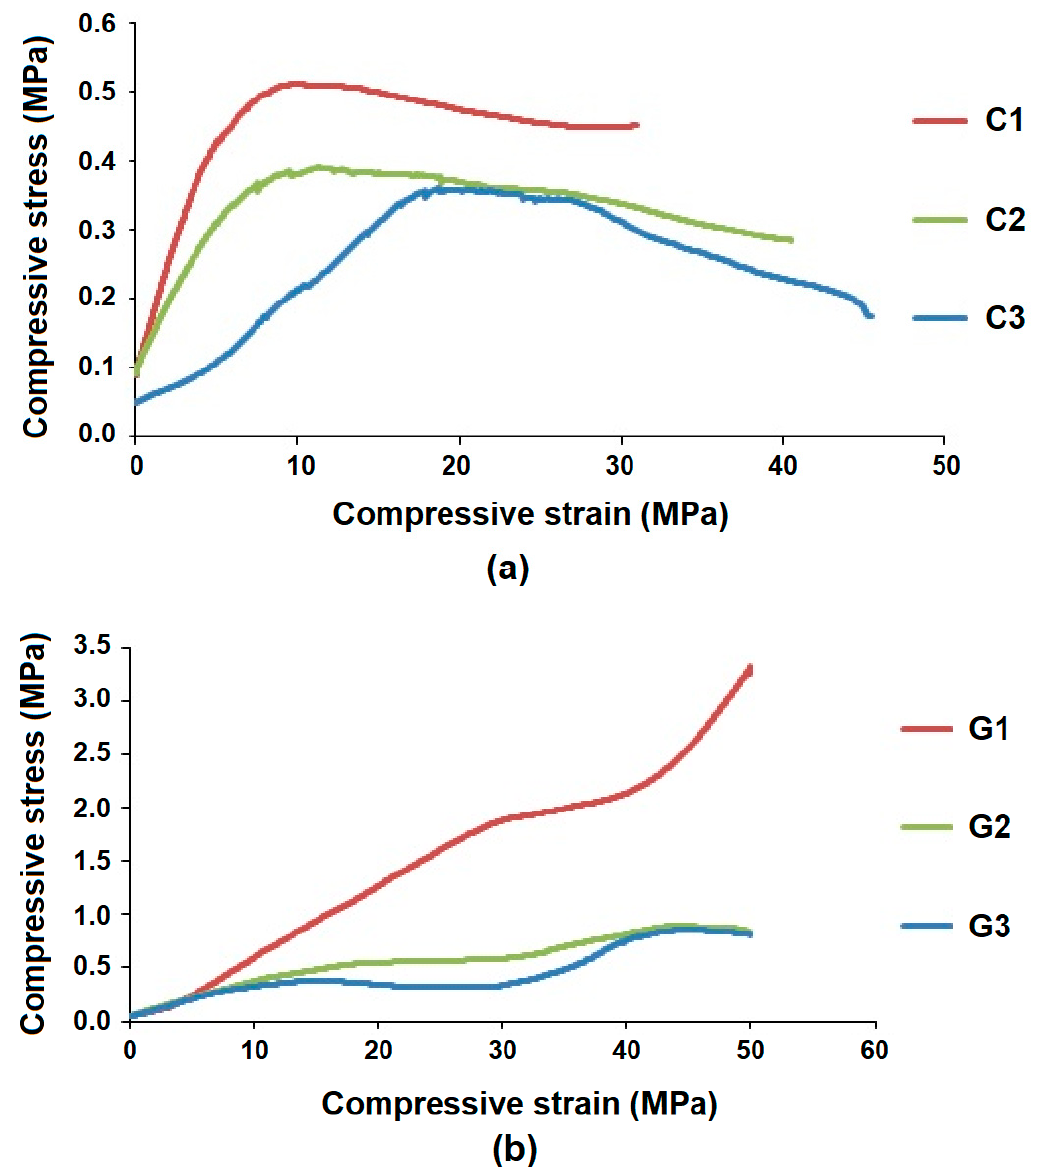
Figure 7. Compressive stress versus strain for ( a ) recycled cotton fiber-based hollow composites and ( b ) glass fiber-based hollow composites.